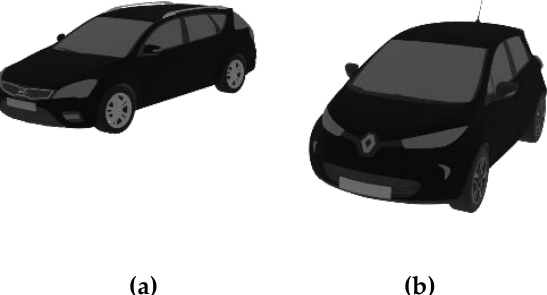
Figure 2. Visual models of the vehicle used in the experiment: ( a ) Kia Ceed SW; and ( b ) Renault Zoe ZE.